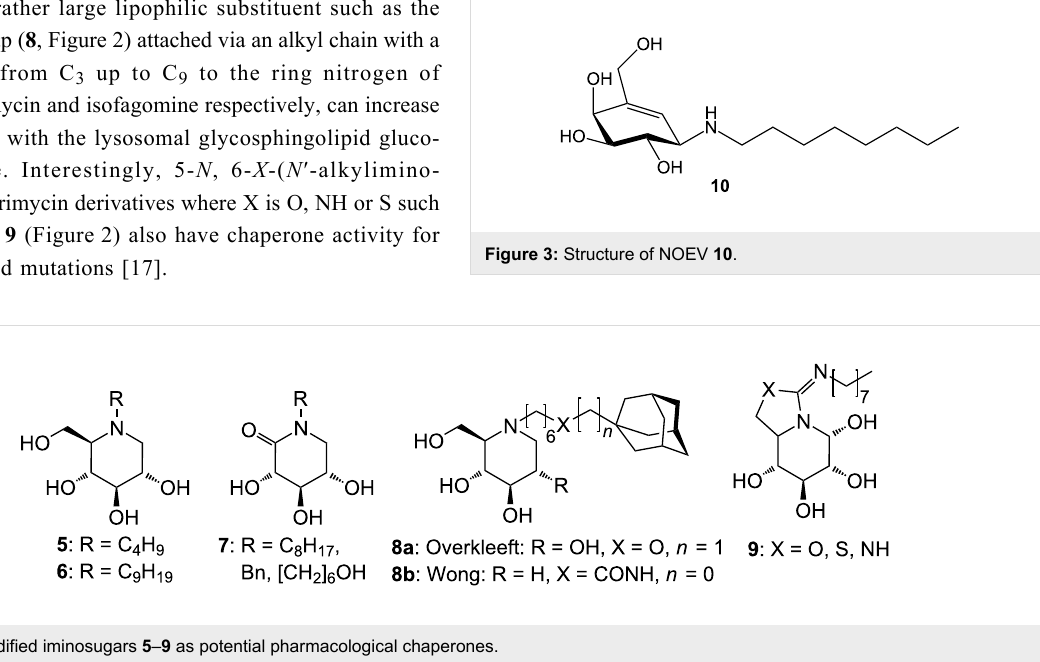
Figure 2: N -Modified iminosugars 5 – 9 as potential pharmacological chaperones.